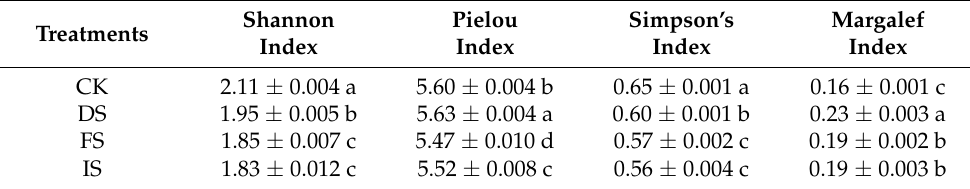
Table 4. Fungal diversity in soils biofumigated with different forms of Tateges erecta.